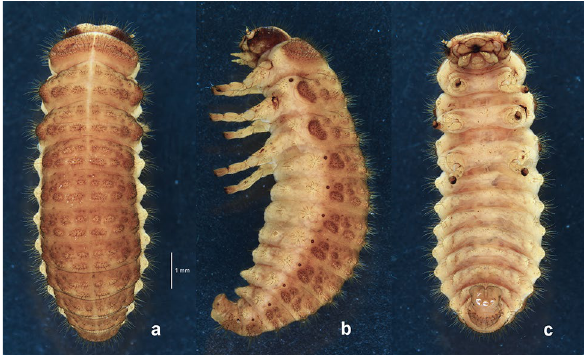
Figure 4. Mature larva of Suinzona borowieci sp. nov.: (a) Dorsal habitus, (b) lateral habitus, (c) ventral